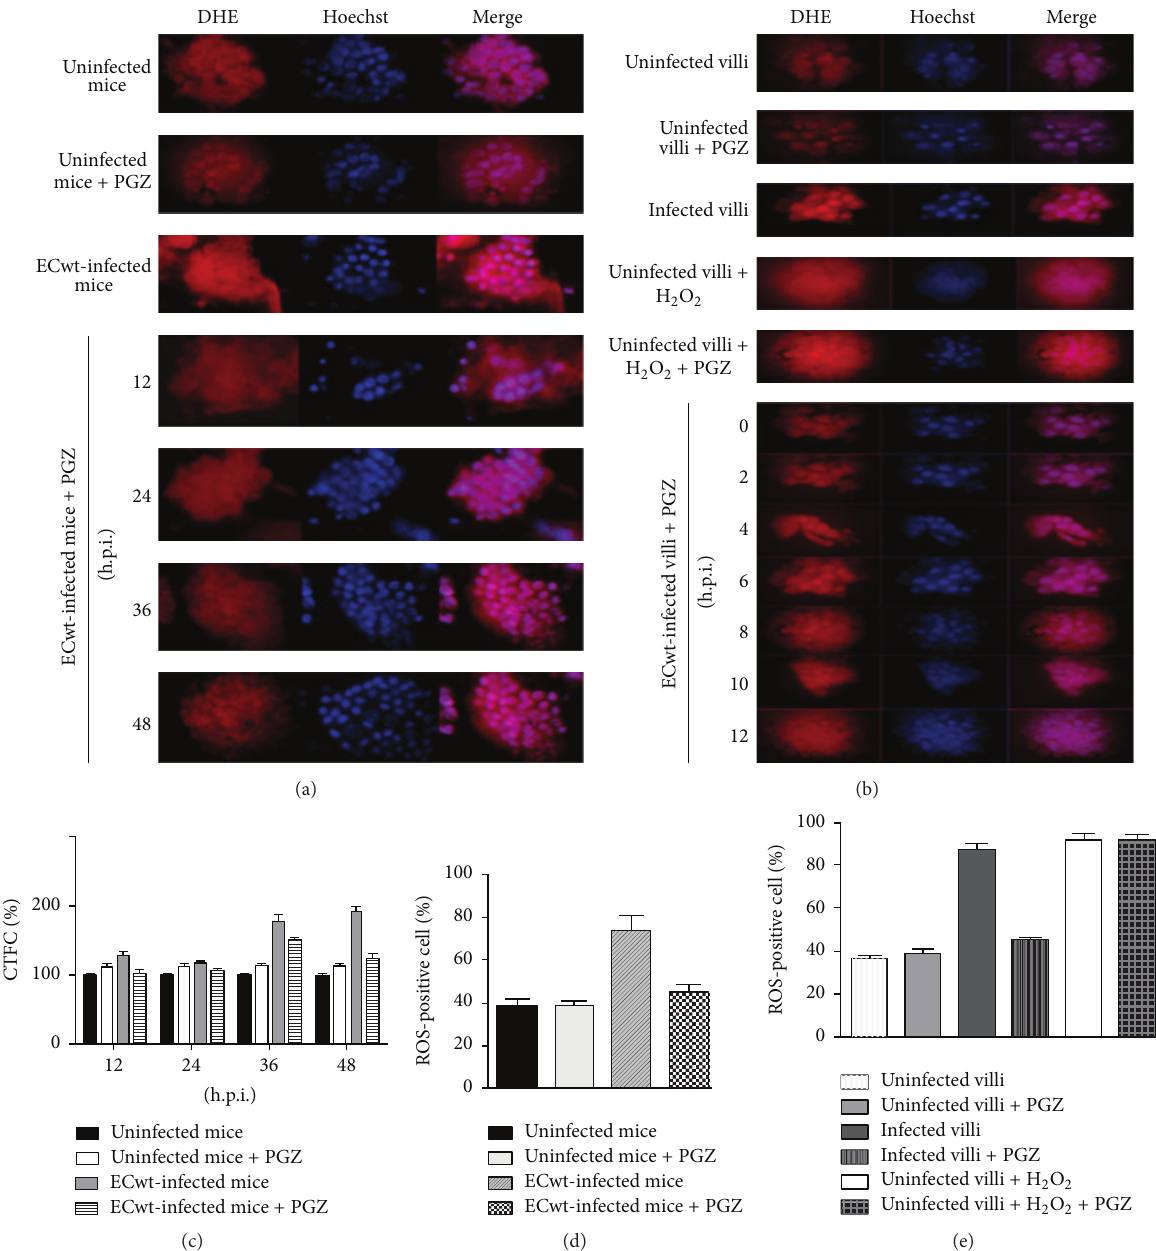
Figure 6: Oxidative stress induction by ECwt infection of small intestinal villi. (a) Small intestinal villi were isolated from EC-infected mice ( 𝑛 = 3 per experiment) that had been treated or not with PGZ. The isolated villi were tested for the presence ROS at the indicated postinfectiontimesusingCellomics (cid:3) OxidativeStress1HCSReagentKit.QuantitativedetectionofROSwasperformedwithDHE.Villuscells were costained with dihydroethidium (DHE) and Hoechst for quantitative detection of ROS and nuclei staining, respectively. Representative micrographs are shown. (b) Small intestinal villi isolated from mice were infected with ECwt and treated or not with PGZ. Villi were collected at the postinfection times indicated and subjected to the procedures indicated in (a). Representative micrographs are shown. (c) Fluorescence of ROS-positive cells at the indicated postinfection times was measured in randomly chosen triplicate fields per slide using the ImageJ program, and the corrected total cell fluorescence (CTCF) values are shown in terms of mean (SD) percentages of uninfected control mice. (d) Small intestinal villi were isolated from EC-infected mice that had been treated or not with PGZ. Villus cells were processed as indicated in (a) and the ROS-positive cells recorded using a fluorescence microscope (VanGuard). Data are expressed as mean percentage of ROS- positive cells through the 48h.p.i. period. (e) Small intestinal villi isolated from mice were infected in vitro with ECwt and treated or not with PGZ. Villus cells were processed as indicated in (a) and the ROS-positive cells recorded as indicated in (d). Data are shown as mean ± SD percentage of ROS-positive cells through the 12 h.p.i. period. Villi treated with H 2 O 2 were used as a control. Data are from three independent experiments performed in